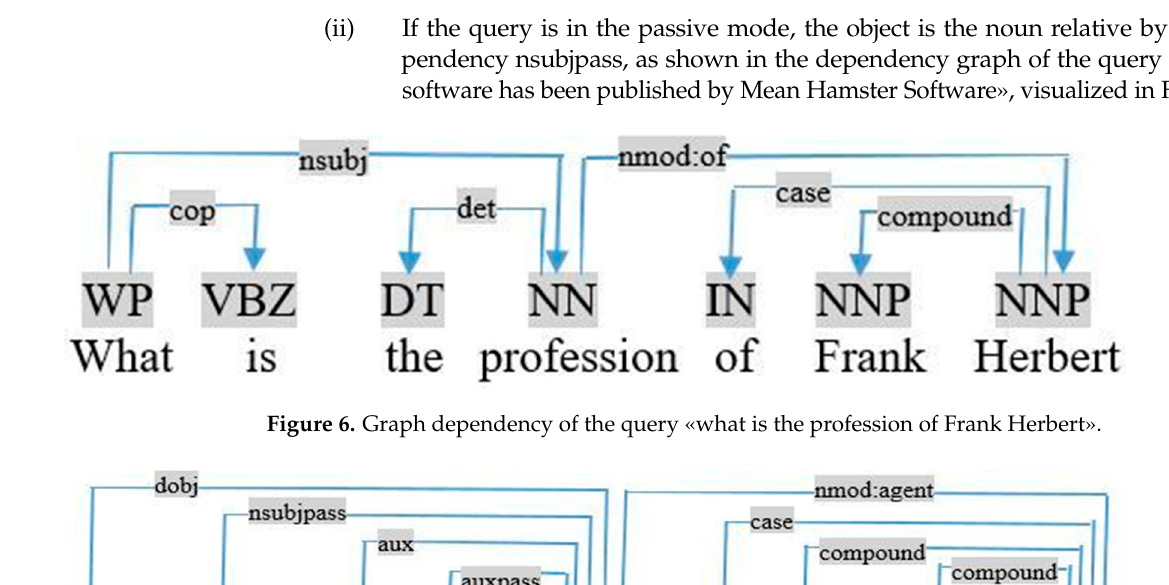
Figure 7. Graph dependency of the query «which software has been published by Mean Hamster Software».